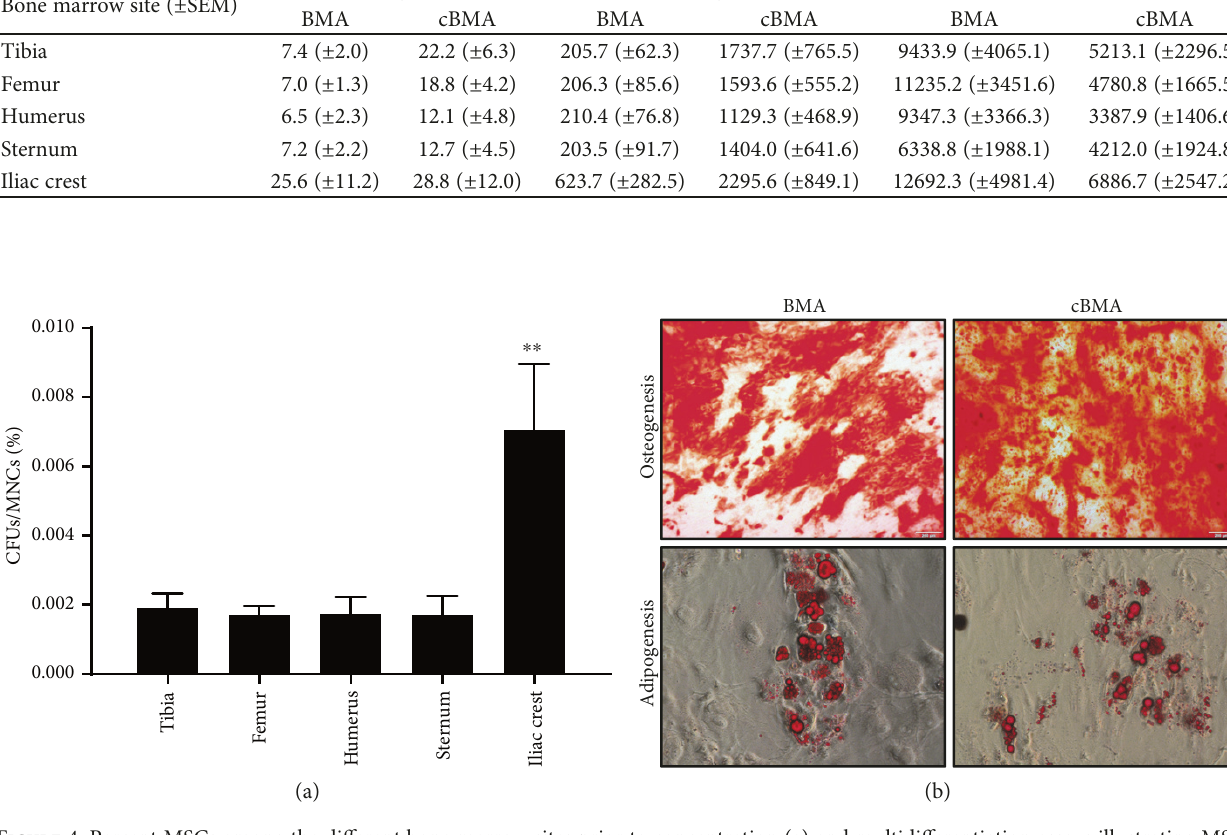
Figure 4: Percent MSCs among the di ff erent bone marrow sites prior to concentration (a) and multidi ff erentiation assays illustrating MSC characteristics of isolated cells from multiple bone marrow sites before and after concentration (b); ∗∗ p < 0 01 . Table 2: Optimal conditions to maximize MSC yield from bone marrow aspirates